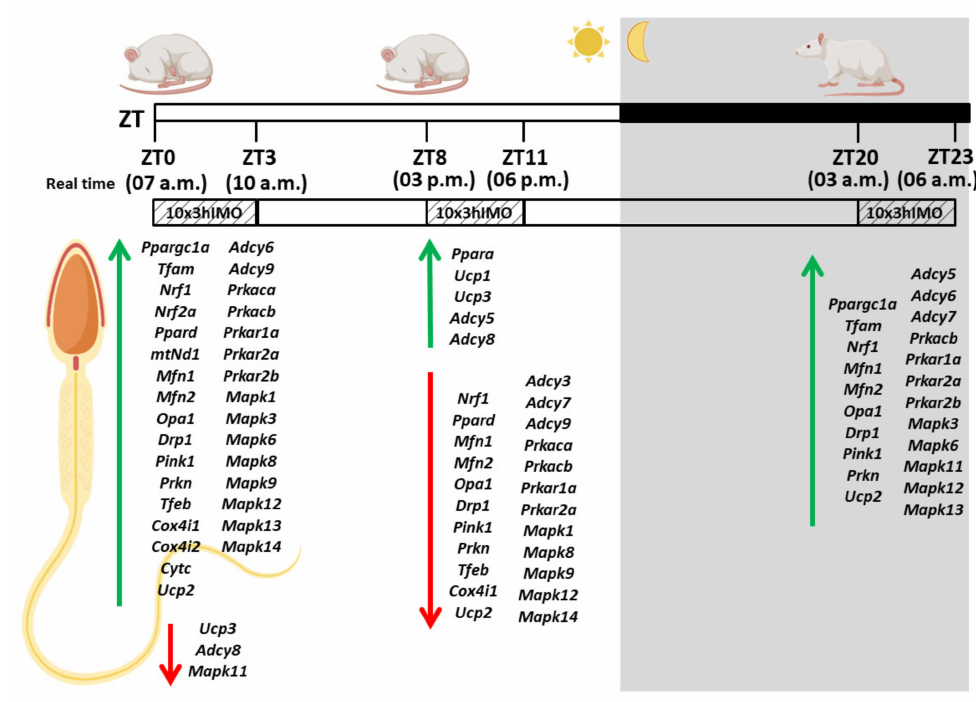
Figure 13. The transcriptional profile of mitochondrial dynamics and functionality markers as well as signaling molecules regulating mitochondrial dynamics and functionality in spermatozoa obtained from adult rats repeatedly stressed at different time points (ZT3, ZT11, and ZT23) during the day. Up arrow symbol represents increased transcription, while down arrow symbol represents decreased